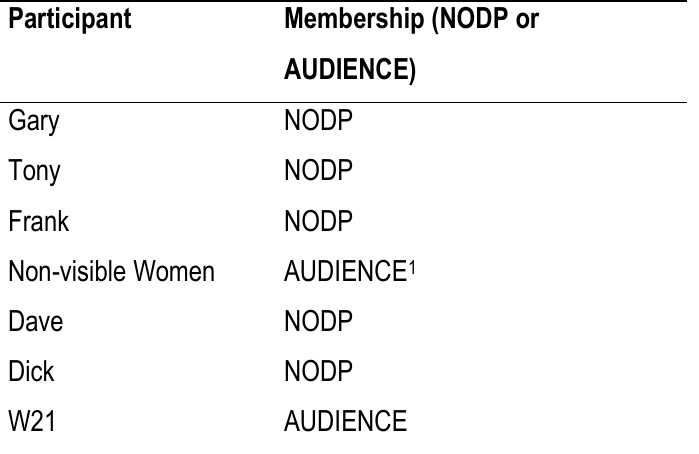
Meeting Participants Taking Six or More